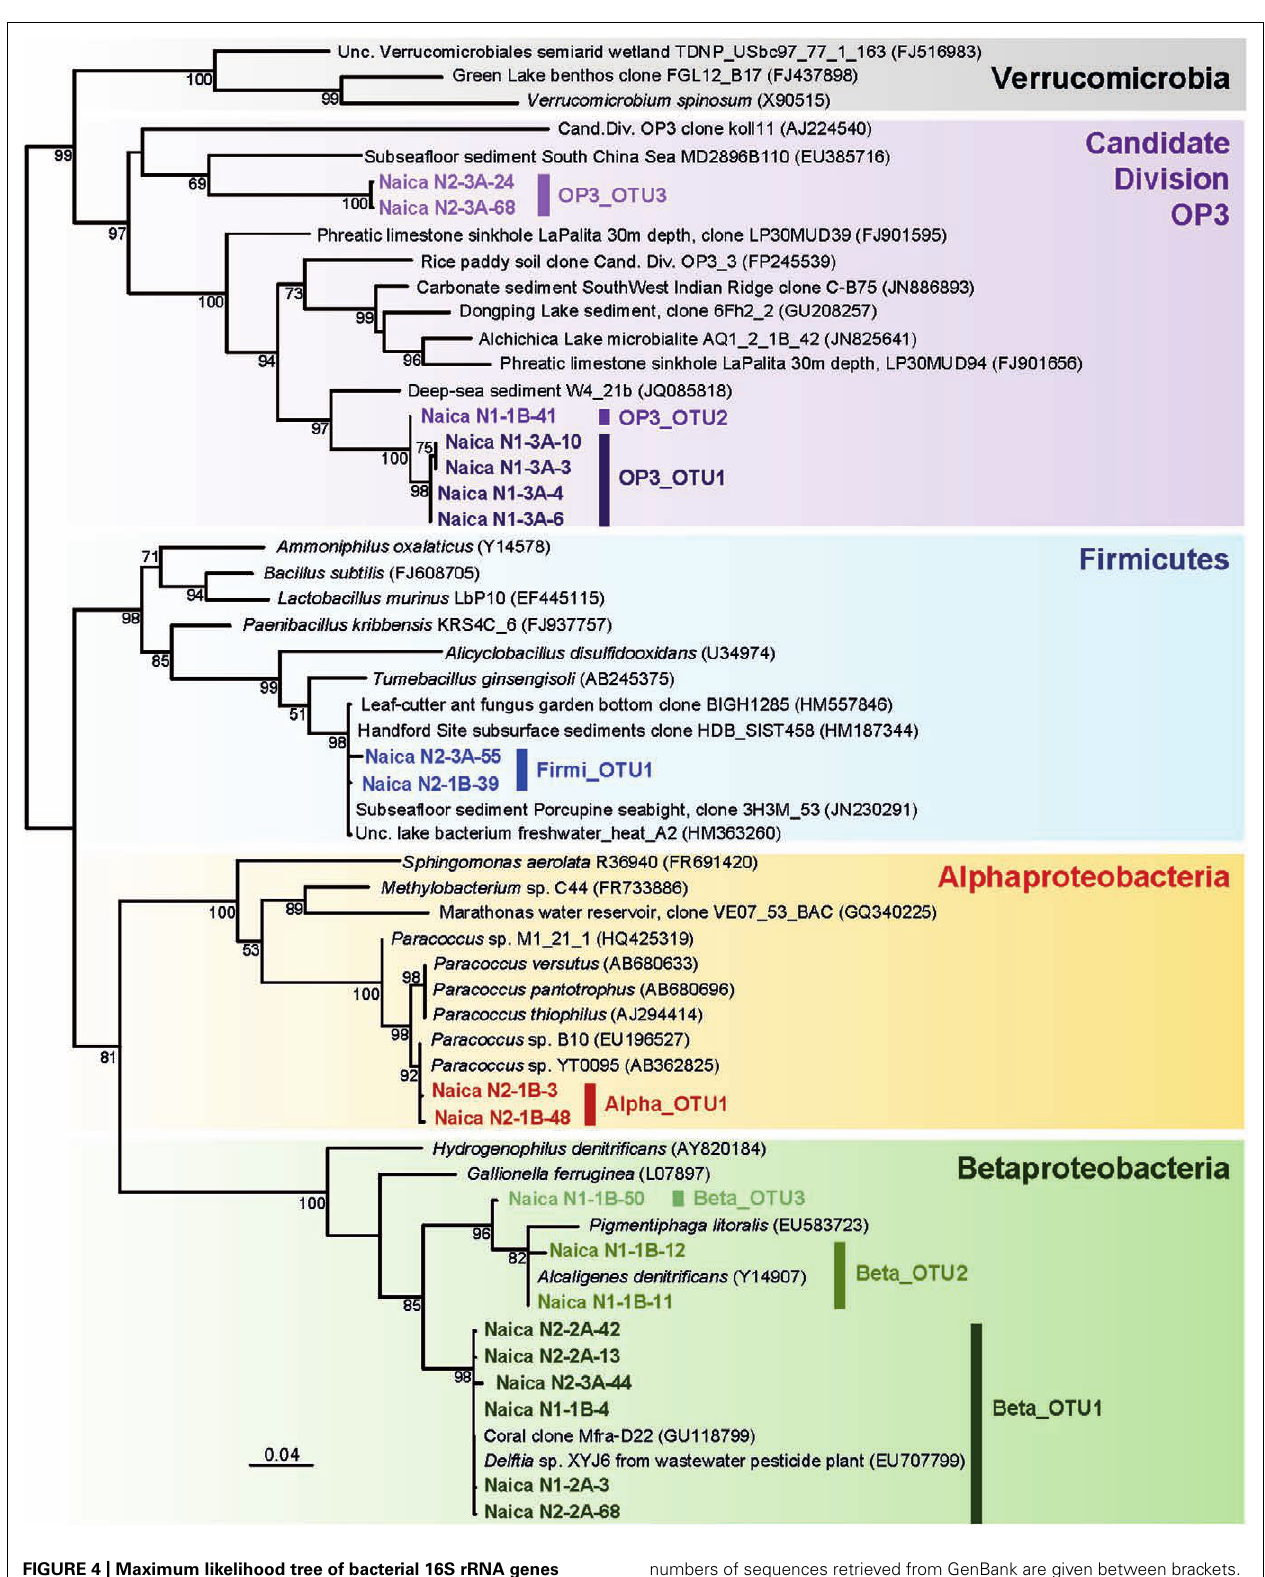
FIGURE 4 | Maximum likelihood tree of bacterial 16S rRNA genes retrieved from Naica deep hot springs. The tree was reconstructed using 846 positions. Sequences obtained in this work are shown in color. Accession